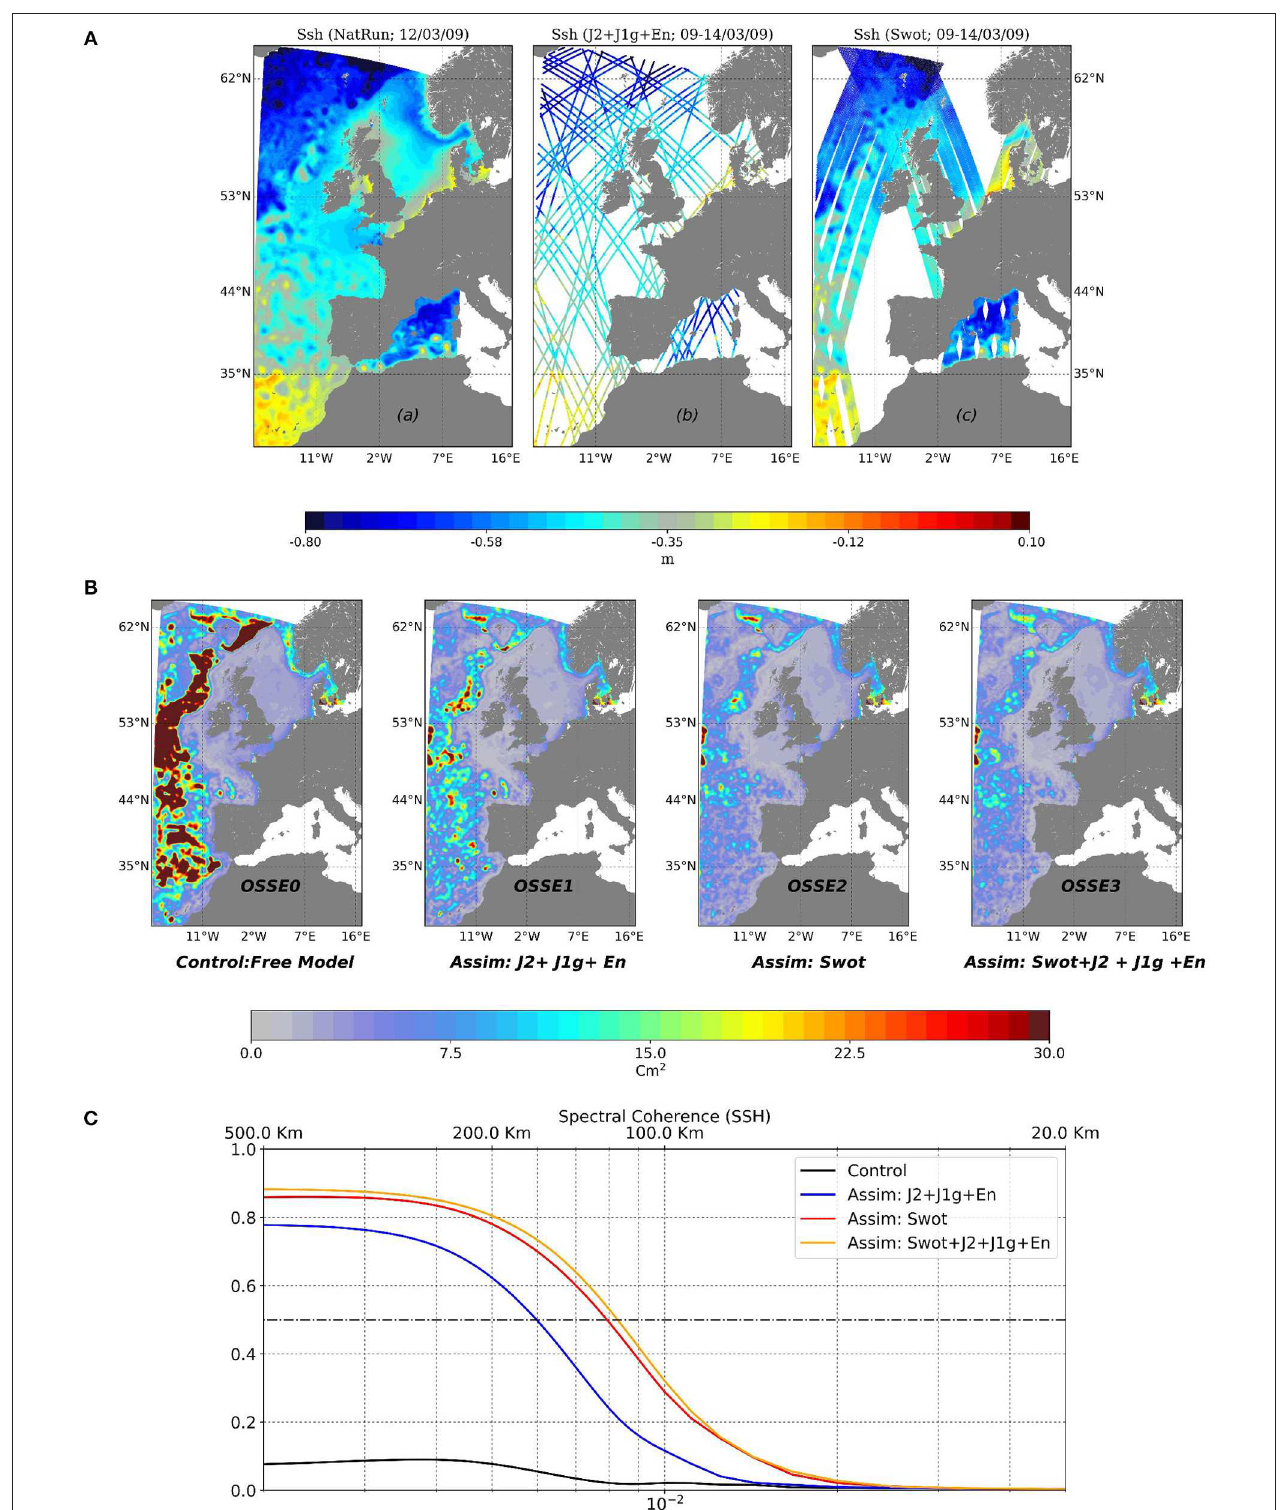
FIGURE 7 | Evaluation of a constellation of nadir and wide-swath altimeters in Mercator. (A) SSH field simulated in the Nature Run on March 12 2009 (left), and synthetic SSH data for Jason2, Jason1g and ENVISAT (middle), and SWOT synthetic data (right) in a 5-day assimilation cycle from March 12 2009. (B) Maps of the variance of SSH errors in the ocean analysis of OSSE0, OSSE1, OSSE2, and OSSE3 (from the left to right) over the IBI domain during 2009. Units in cm 2 . (C) Spectral coherence in OSSE0 (black line), OSSE1 (blue line), OSSE2 (red lines), OSSE3 (orange lines) with respect to the Nature Run.